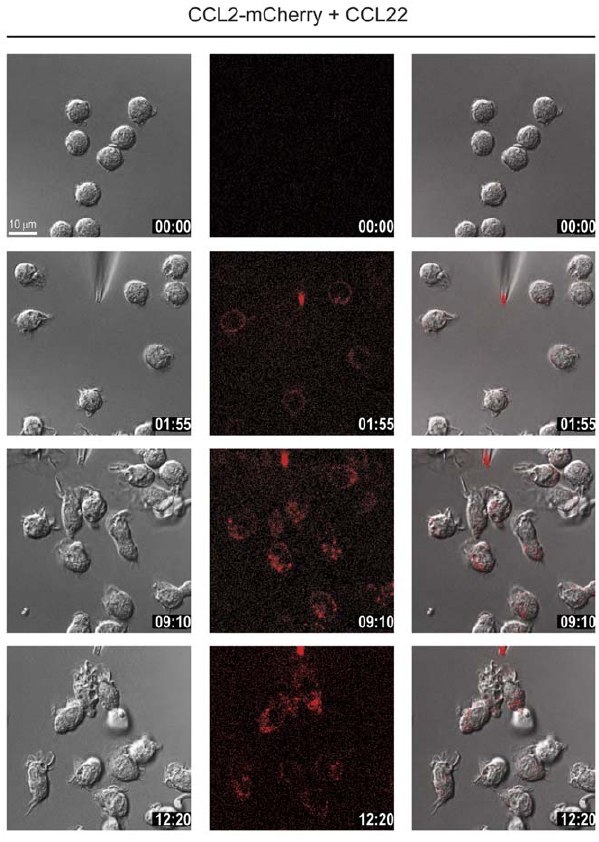
Figure 3. CCL2-mCherry uptake is not due to pinocytosis. Selected frames from time-lapse video microscopy (Movie S4) of migrating monocytes recorded at 37 u C. The micropipette was dispending 1 m M CCL2-mCherry and 1 m M CCL20-EYFP with constant backpressure. Left panels CCL2-mCherry (ex 594 nm/em 620–680 nm), middle panels CCL20-EYFP (ex 488 nm/em 500–520 nm), and right panels merged frames overlaid with the corresponding phase image. Time stamps are indicated in mm:ss.